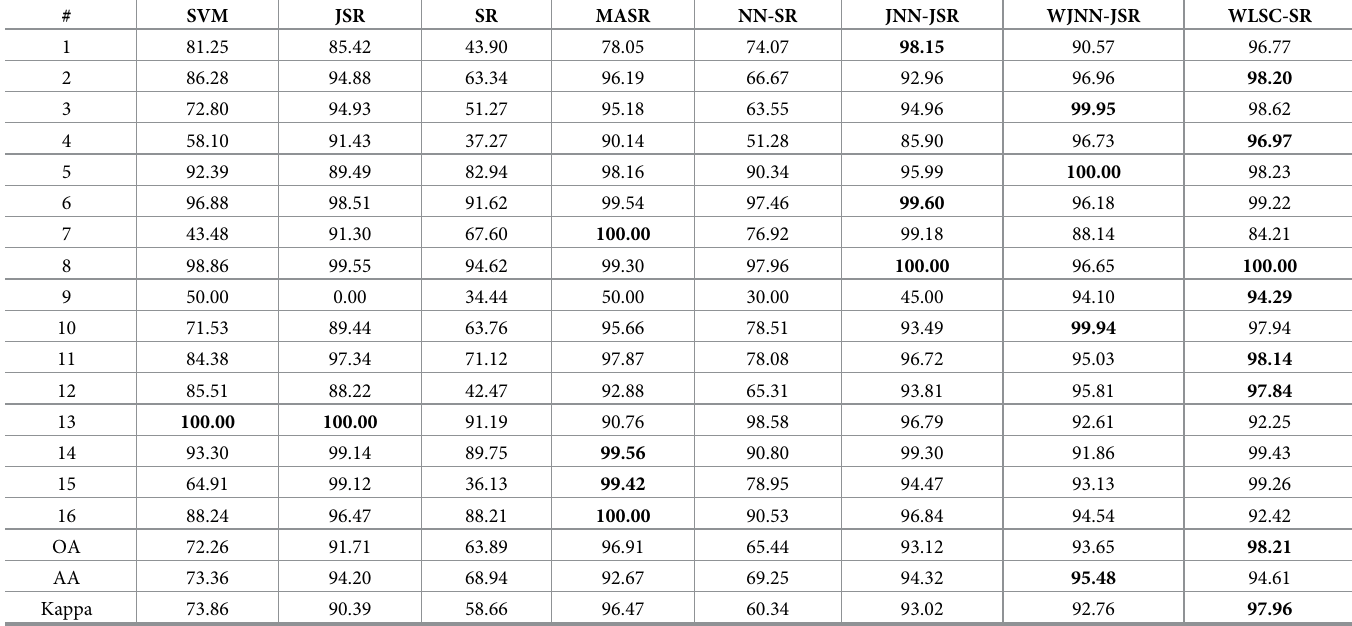
Table 2. Classification accuracy (in percent) of the Indian Pines in the SVM [1], JSR [17], SR [16], MASR [19], NN-SR [18], JNN-JSR [27], WJNN-JSR [27], and